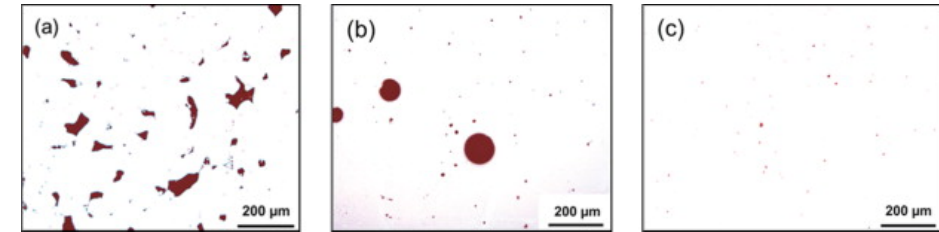
Figure 20. Polished micro-sections for Al-12Si alloy processed by selective laser melting [135]. Samples prepared with ( a ) low energy density (20 J/mm 3 ), no base plate heating and no post-build stress relief, ( b ) high energy density (39.6 J/mm 3 ), 200 °C base-plate heating and no post-build stress relief, and ( c ) high energy density (39.6 J/mm 3 ), 200 °C base-plate heating and 240 °C post-build stress relief. Copyright 2015. Adapted with permission from Elsevier Science Ltd. under the license number